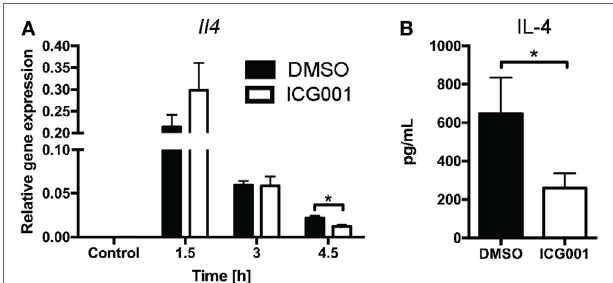
FigUre 4 | β -catenin activity promotes IL-4 expression upon α - galactosylceramide ( α -GalCer) challenge. Mice were treated with ICG001, then challenged with α -GalCer. (a) The mRNA expression of Il4 in the liver was determined by quantitative PCR. (b) Serum concentrations of IL-4 at 6 h after α -GalCer challenge. Data are means ± SEM from four to nine mice per treatment for each time point analyzed cumulatively in two to three independent experiments. Groups were compared by t -test at each time point; * p <